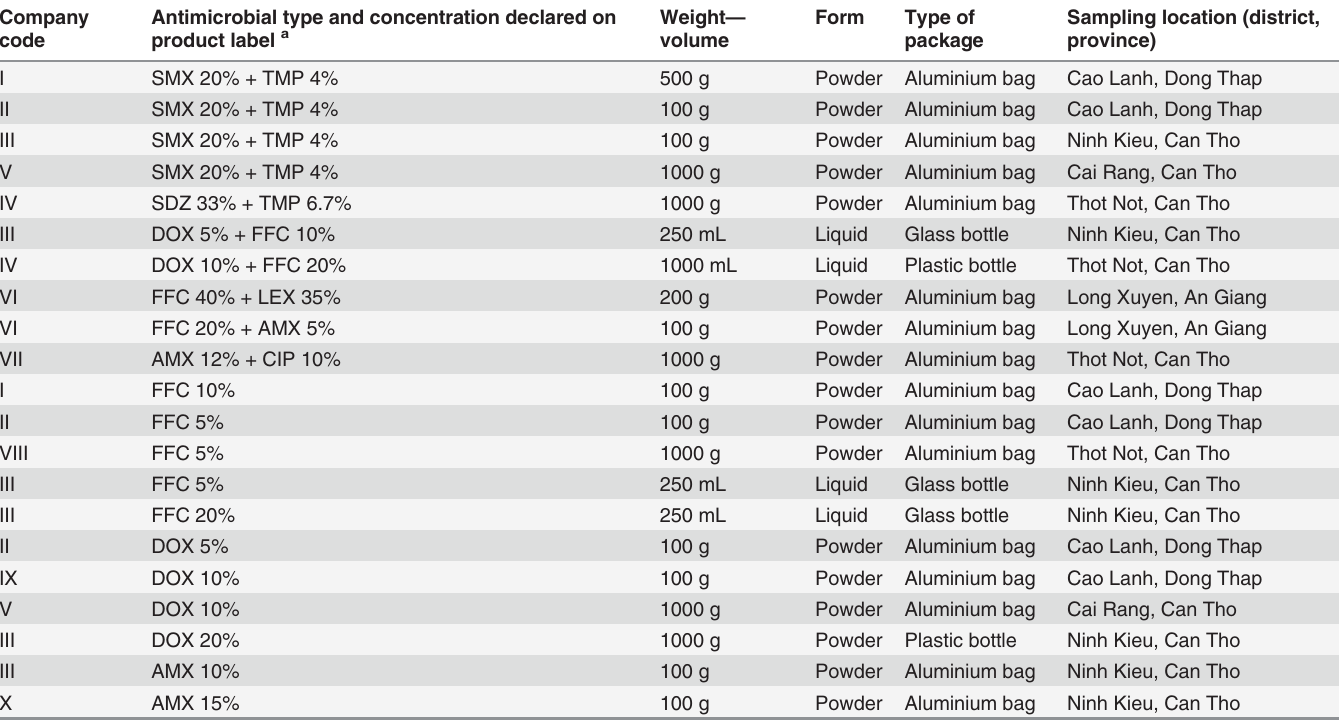
Table 1. Information about the 21 antimicrobial products analyzed. Company Antimicrobial type and concentration declared on code product label